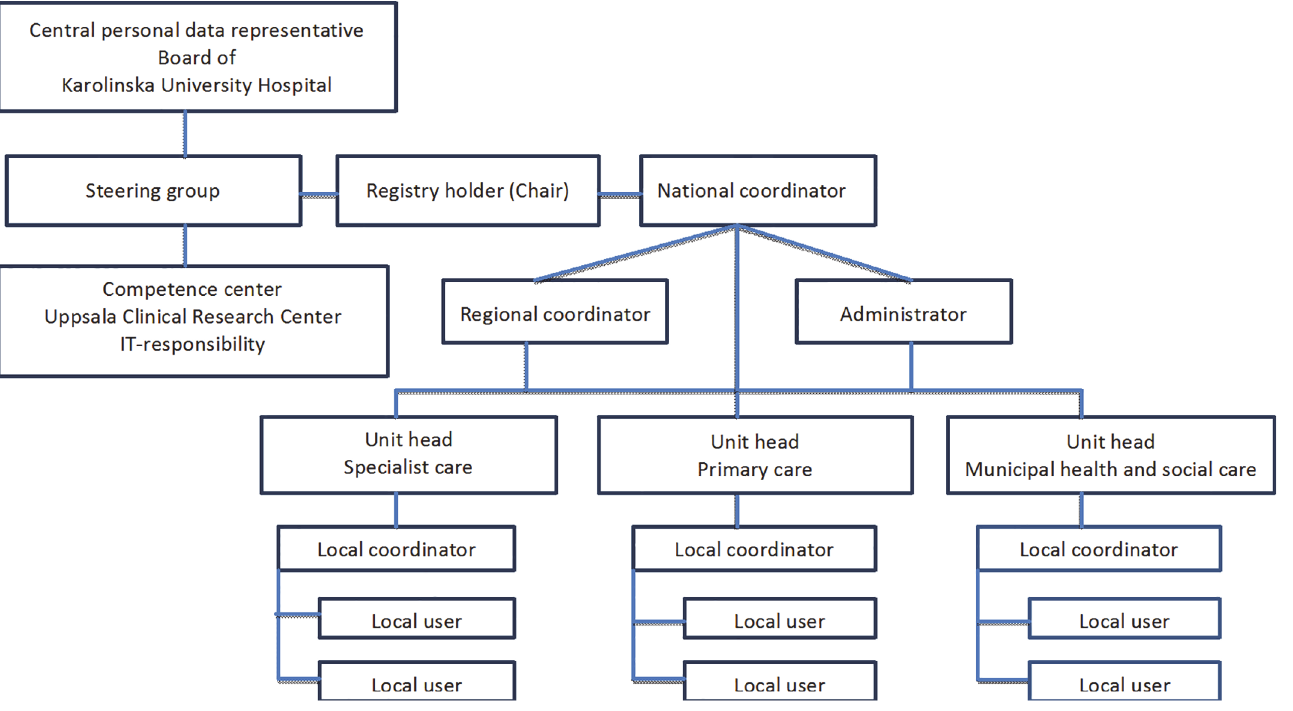
Fig 1. Organisational structure of SveDem.